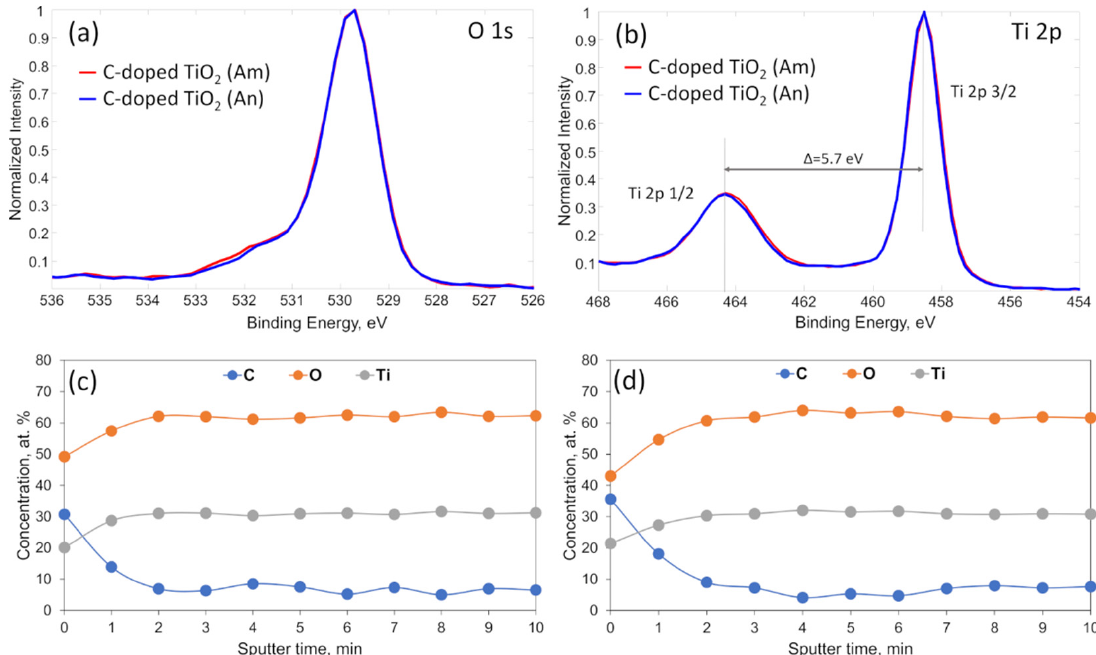
Figure 5. ( a ) O1s and ( b ) Ti2p XPS spectra of amorphous (red) and anatase (blue) carbon-doped TiO 2 films, and depth profiles of ( c ) anatase and ( d ) amorphous carbon-doped TiO 2 films.